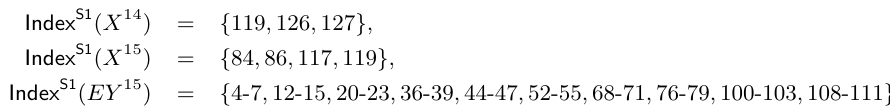
bit positions that should be